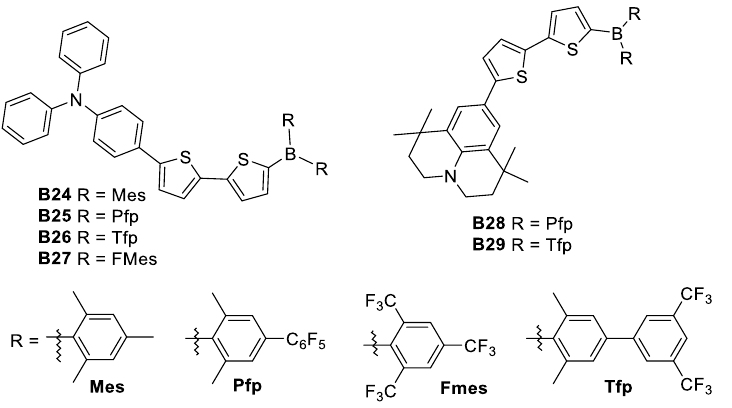
Figure 18. Substitution of the methyl substituents para to the boron atom by electron-withdrawing perfluorophenyl.